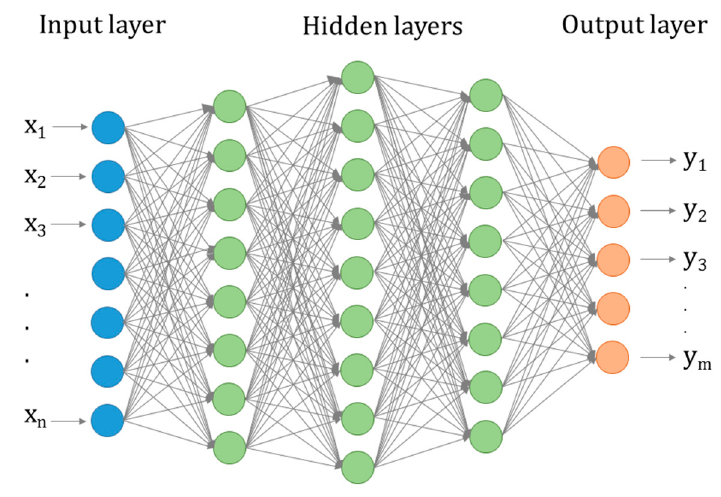
Figure 1. Scheme of an Artificial Neural Network.